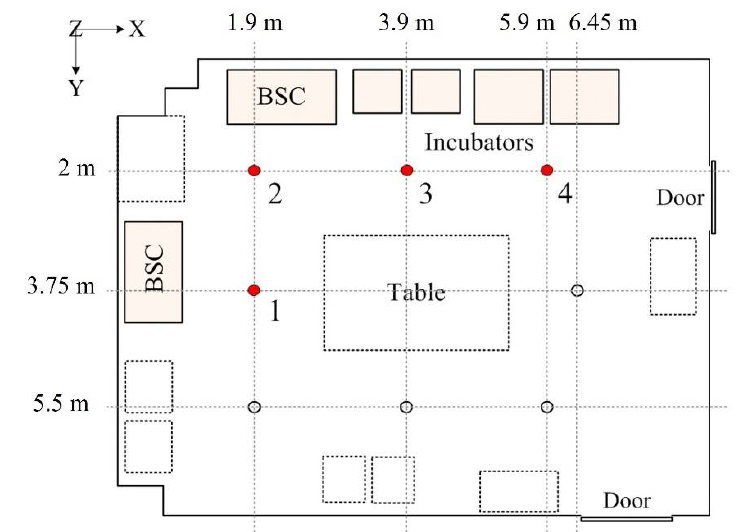
Figure 3. Layout of the monitoring points at the height of 1.6 m.